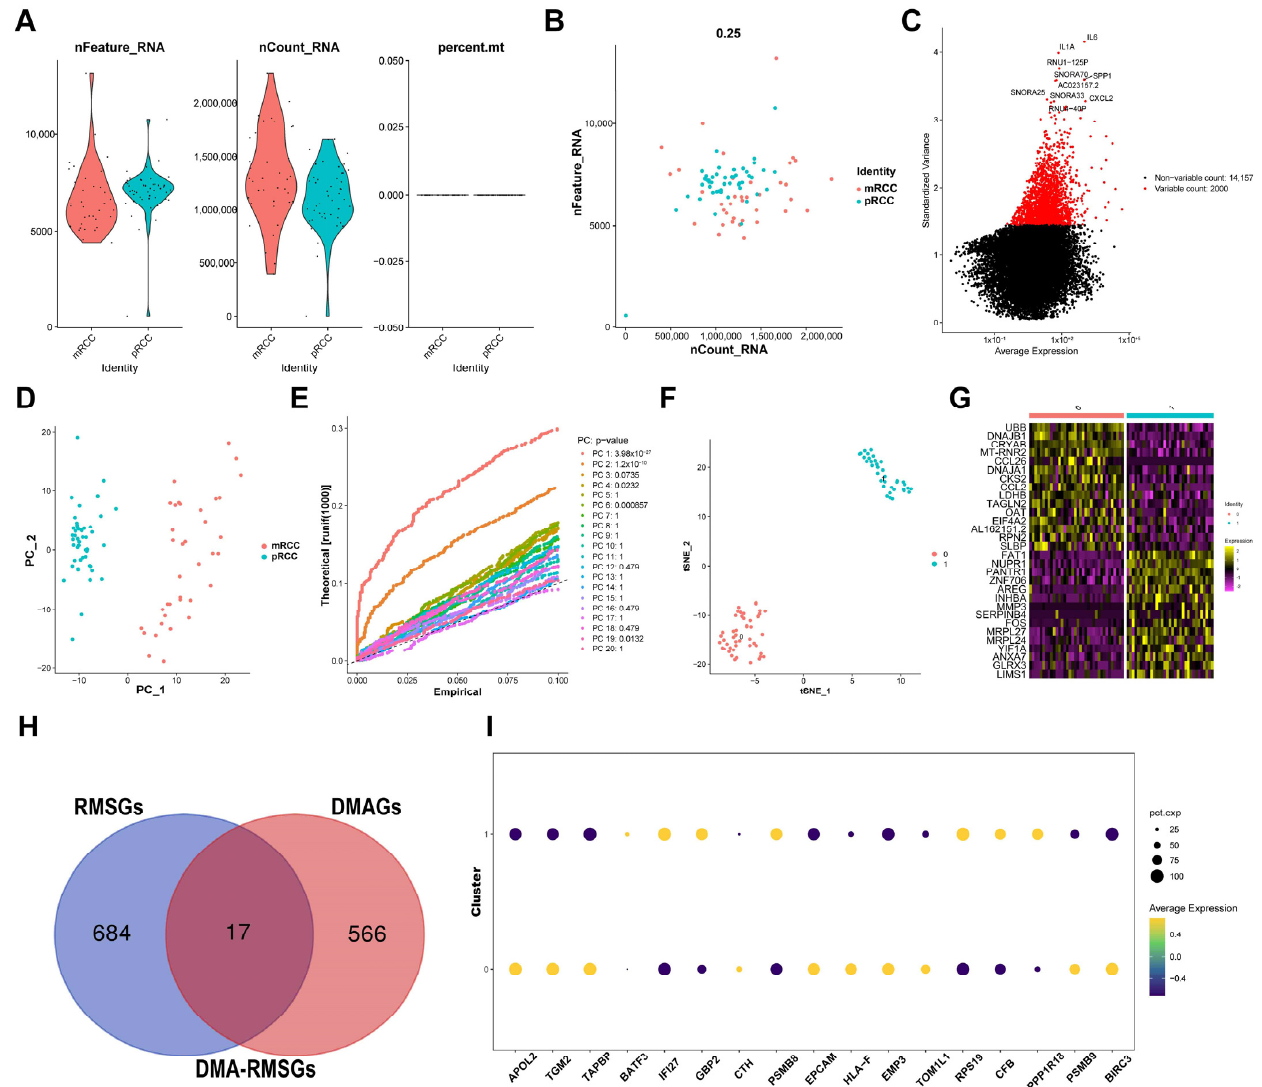
Figure 6. Single-cell RNA sequencing data in GSE73121 and DMA − RMSGs screening. ( A ) Quality control was performed to filter the ccRCC cells with poor quality. ( B ) Scatter plot shows a positive correlation between gene counts and sequencing depth. ( C ) Genes with high variability across cells were identified using a characteristic variance plot. ( D ) The two distinct distributions of ccRCC cell groups were obtained using the PCA method. ( E ) Significant principal components were screened using the estimated p -value. ( F ) ccRCC cells were further classified into two subgroups using the t-SNE algorithm. ( G ) Heat map displays the independent expression patterns of the top 30 DMAGs between the two subgroups. ( H ) Key DMA-RMSGs were obtained according to the intersection of RMSGs and DMAGs. ( I ) Dot plot presents the differential expression levels of the 17 DMA-RMSGs between the two ccRCC